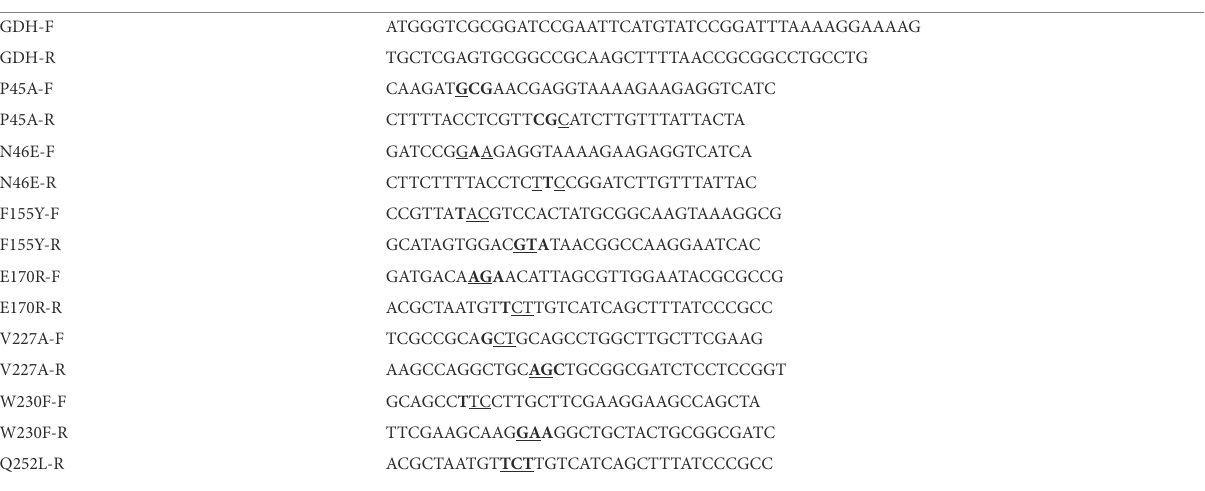
Underlined text indicates mutant bases, while bold text indicates mutated amino acid